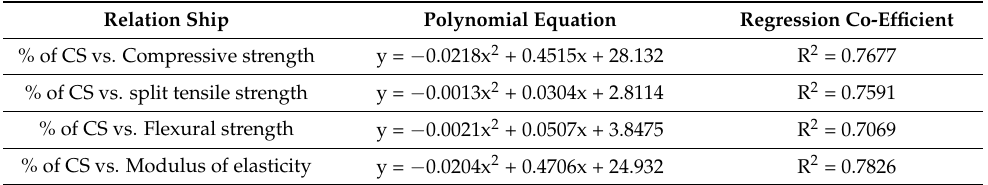
Table 7. Regression equation for CS